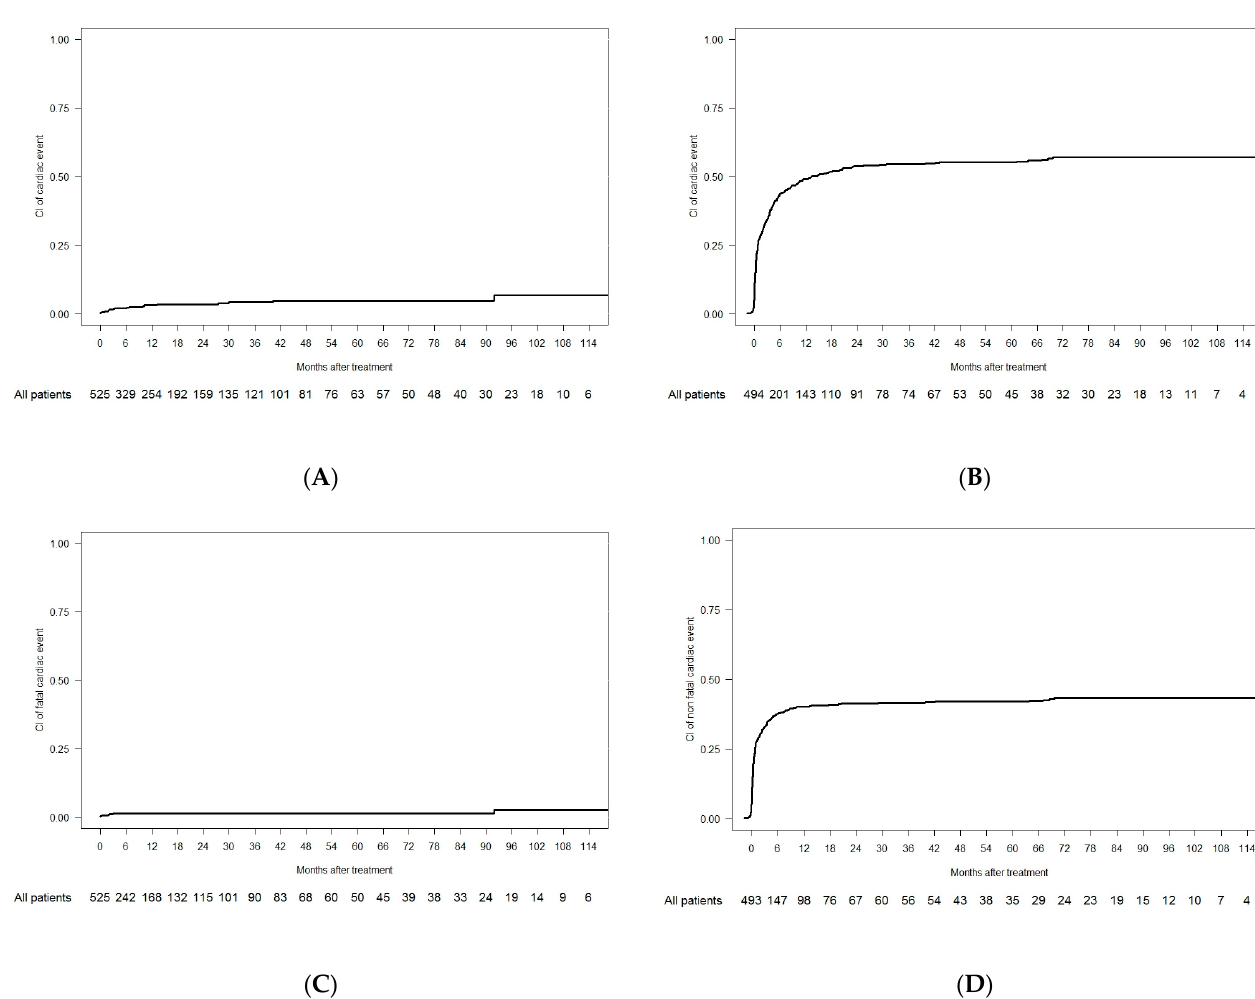
Figure 1. Cumulative incidence of cardiac events. ( A ) CI of fatal cardiac events in the overall cohort; ( B ) CI of non-fatal cardiac events in the overall cohort; ( C ) CI of fatal cardiac events in the 1L cohort; ( D ) CI of non-fatal cardiac events in the 1L cohort. Table 3. Overall cohort: Crude and cumulative incidence of cardiac events (fatal vs. non-fatal vs. no cardiac event) according to demographic, clinical, and biological characteristics of patients at diagnosis.